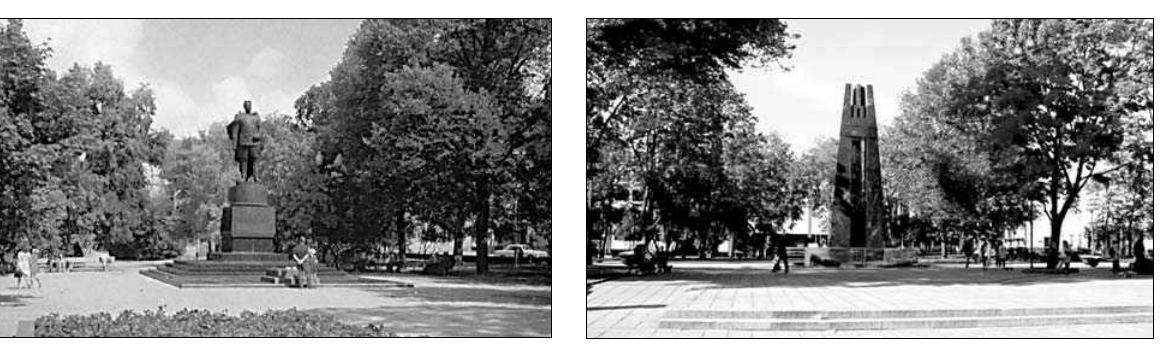
Fig. 3. Monument to General cherniachovsky on his grave